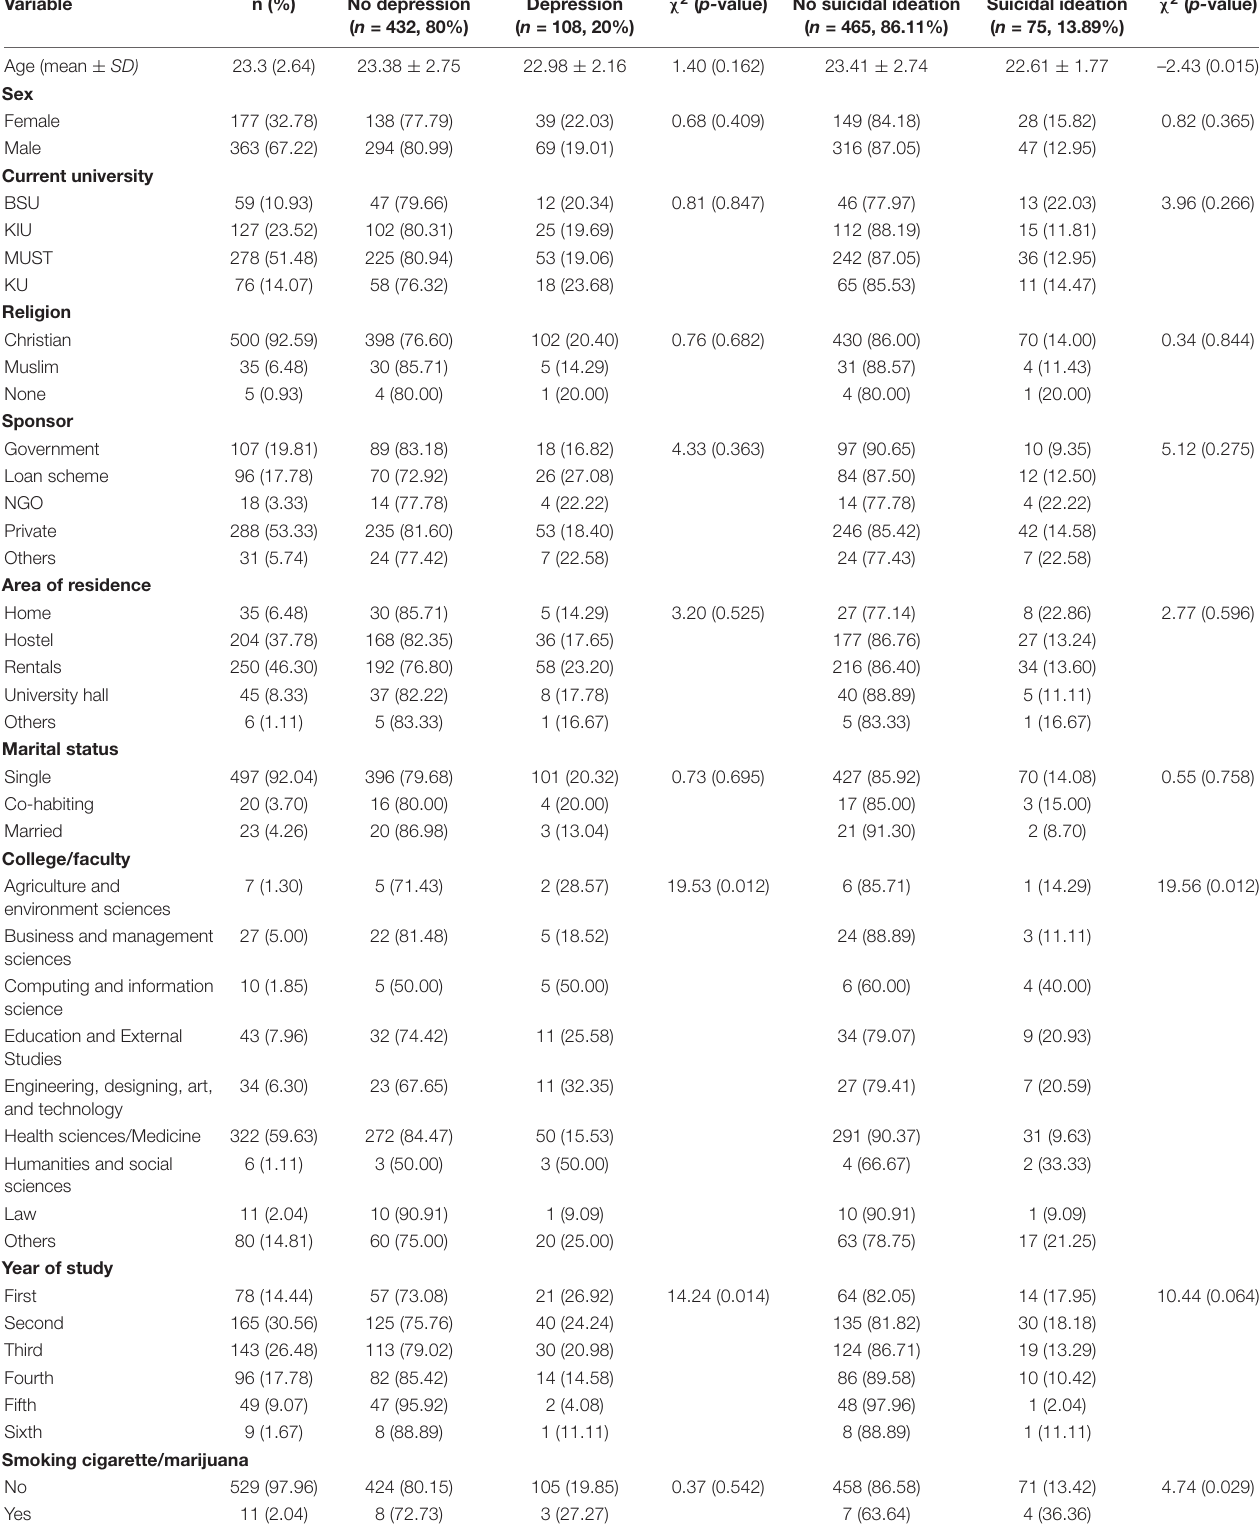
TABLE 1 | Distribution of the studied factors with depression and suicidal ideation ( N =